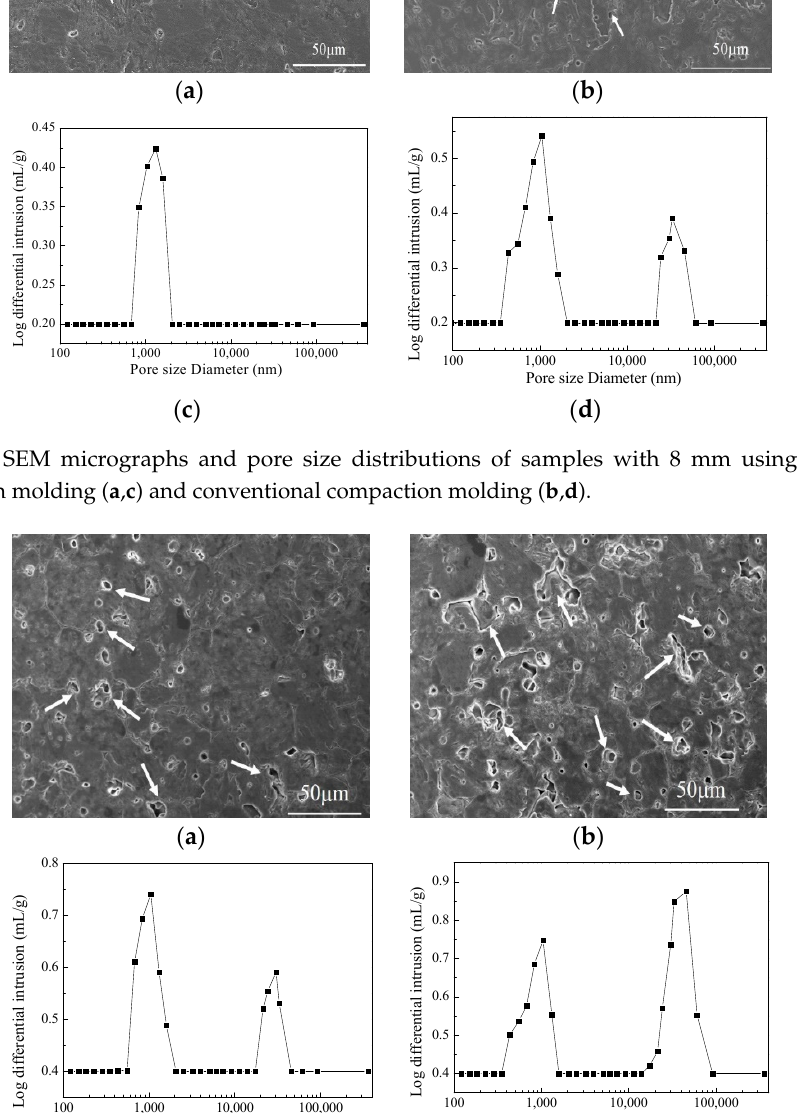
Figure 4. SEM micrographs and pore size distributions of samples with 8 mm using vacuum compaction molding ( a , c ) and conventional compaction molding ( b , d ).